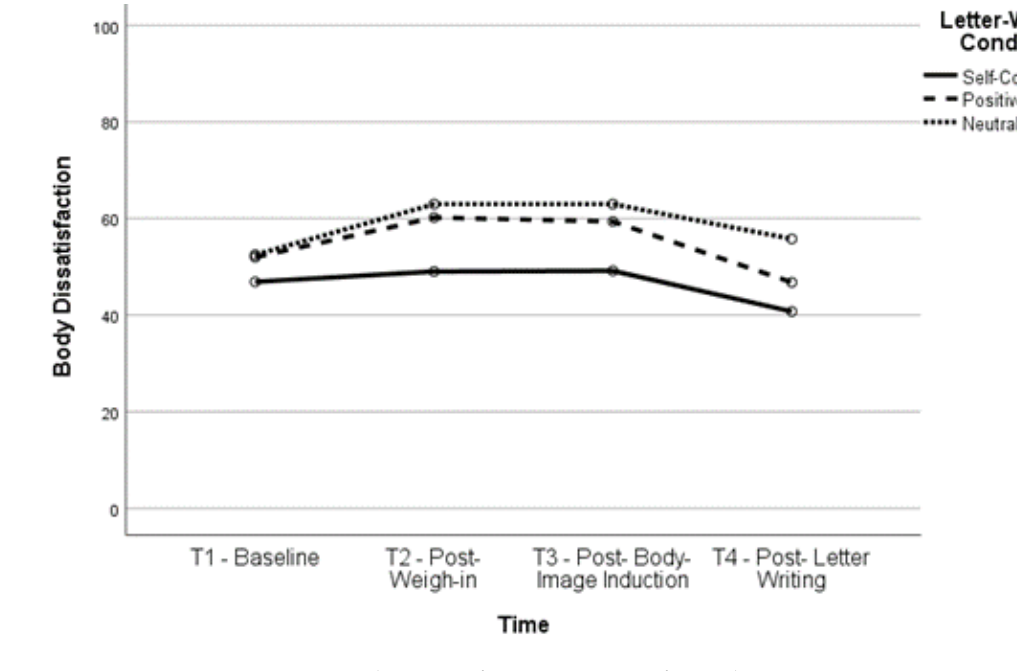
Figure 4. Body Dissatisfaction Over Time for Higher BMI Group.